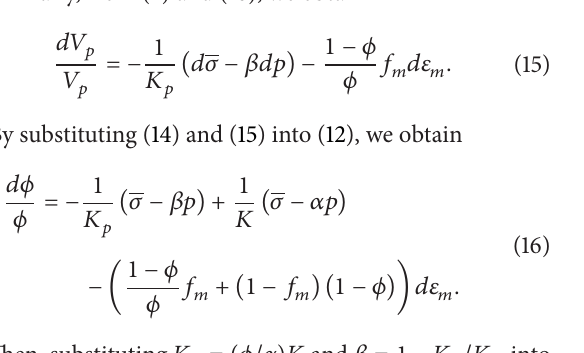
Table 1: Parameter magnitudes for matching the experimental